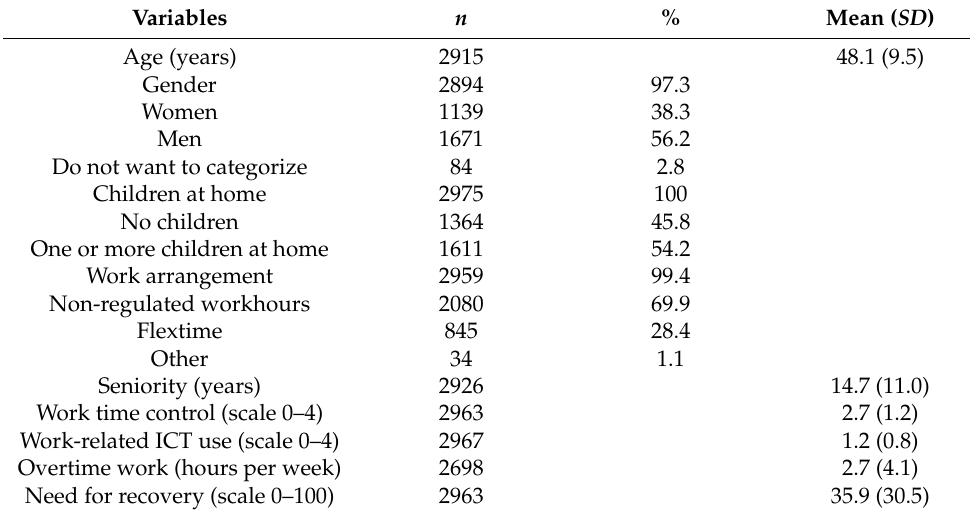
Table 1. Sample demographics. The values show the number ( n ) and percentage of respondents (with n = 2975 being 100%) for categorical variables and mean values with standard deviation ( SD ) for scales.